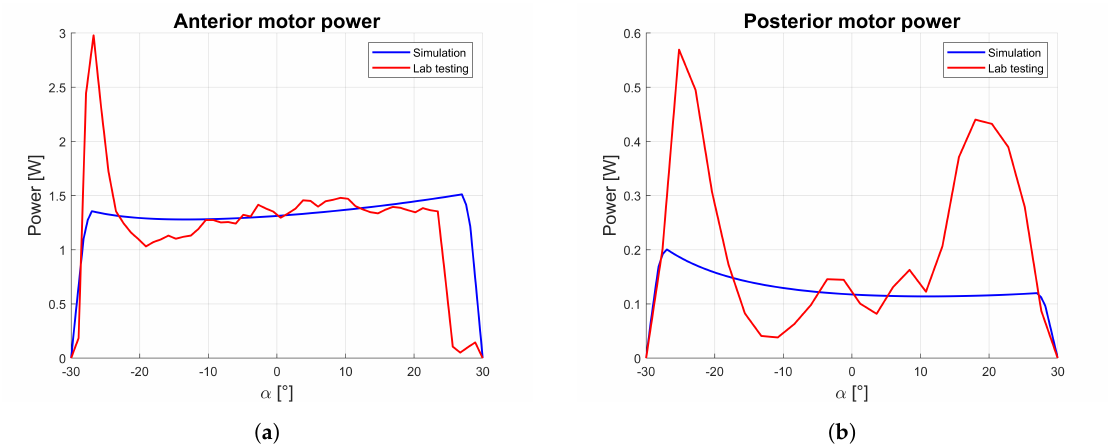
Figure 12. Comparison between results from simulation and lab testing in terms of motor power consumption during: ( a ) flexion motion; ( b ) extension